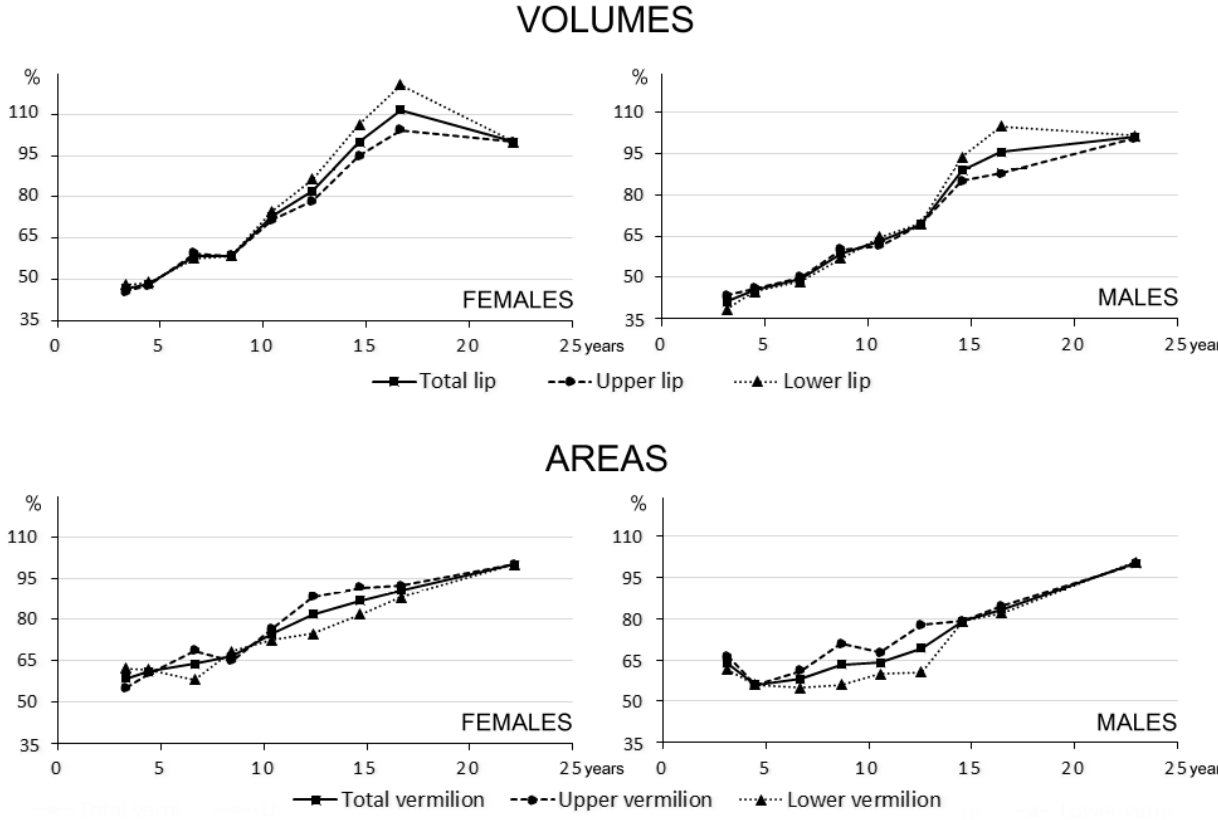
Figure 2. Age-related variations of soft tissue lip volumes and vermilion areas in females and males.